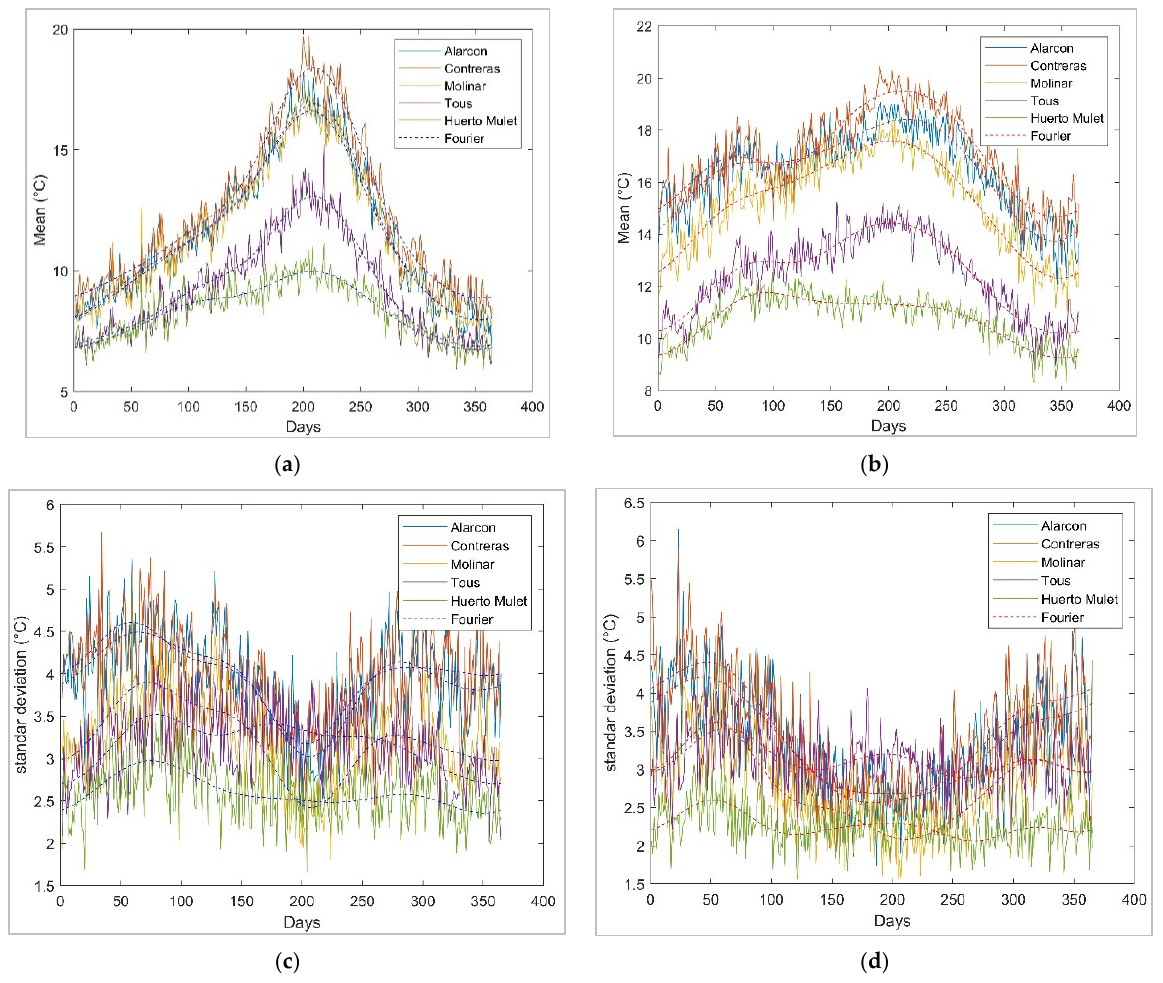
Figure 5. Fourier series (daily average) of maximum temperature series (66 years): ( a ) mean wet days, ( b ) mean dry days, ( c ) standard deviation wet days, and ( d ) standard deviation dry days.